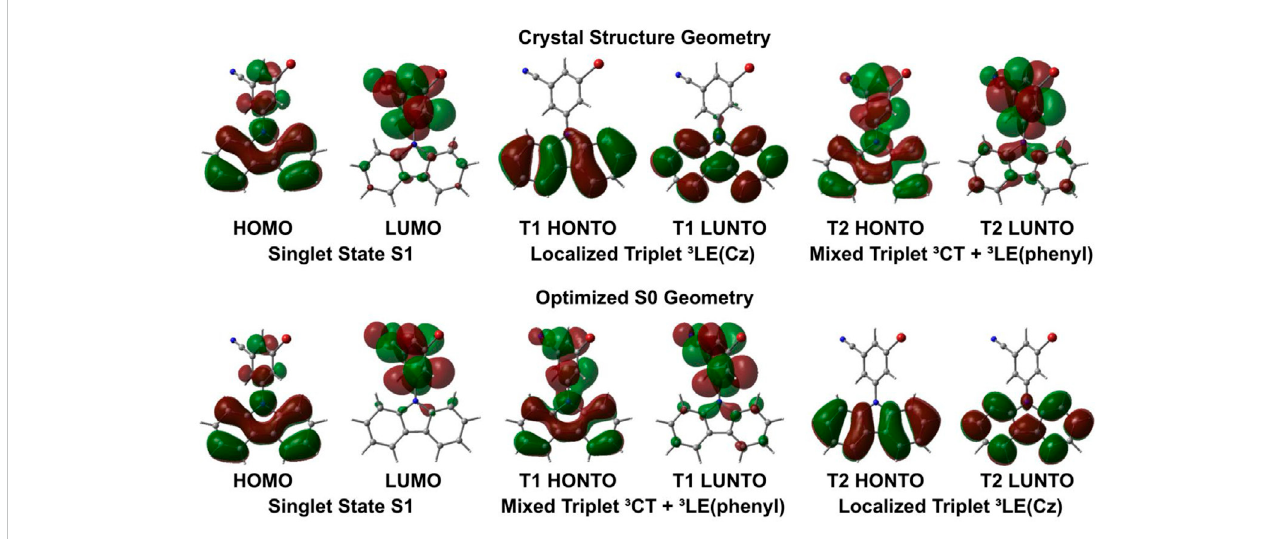
FIGURE 4 Calculated HOMO, LUMO, HONTO, and LUNTO plots of RTP-Br calculated from crystal geometries and optimized S0 geometries.